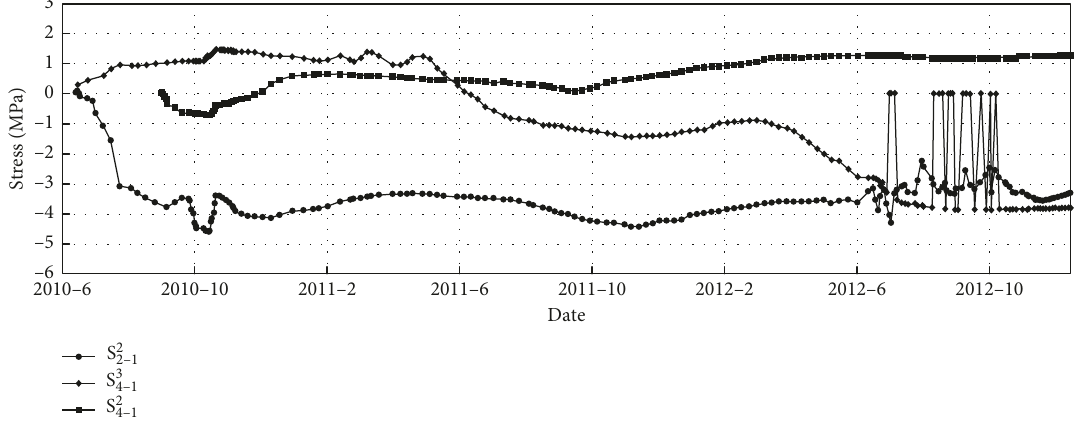
Figure 7: Rebar horizontal stress time series at the 3255m elevation.